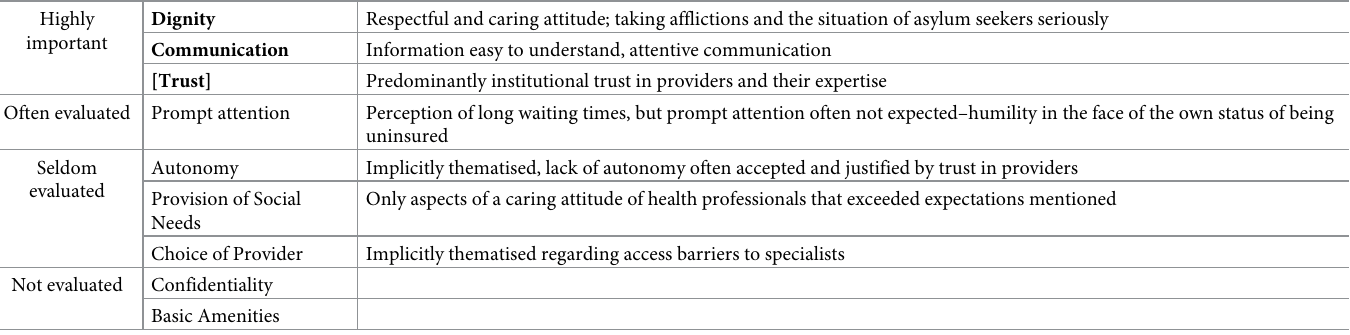
Table 2. Evaluation of responsiveness domains emerging in the